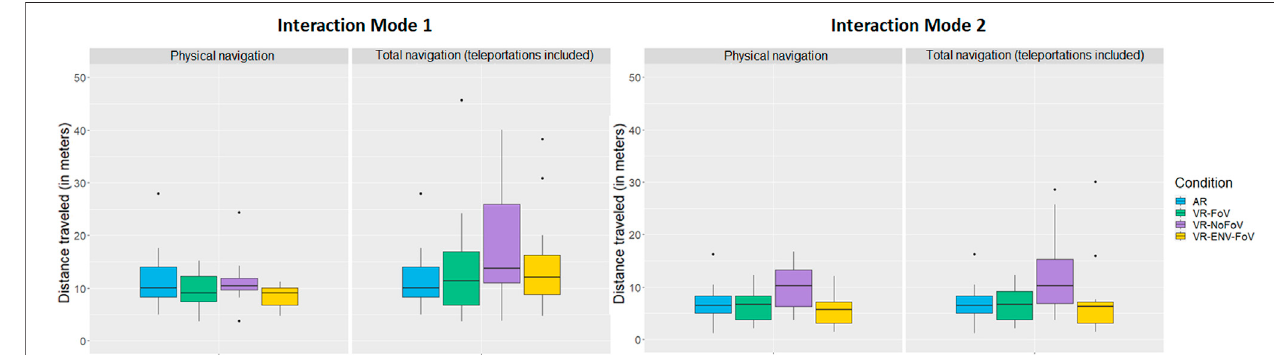
FIGURE 5 | Traveled distances (physical and total) for both interaction modes.